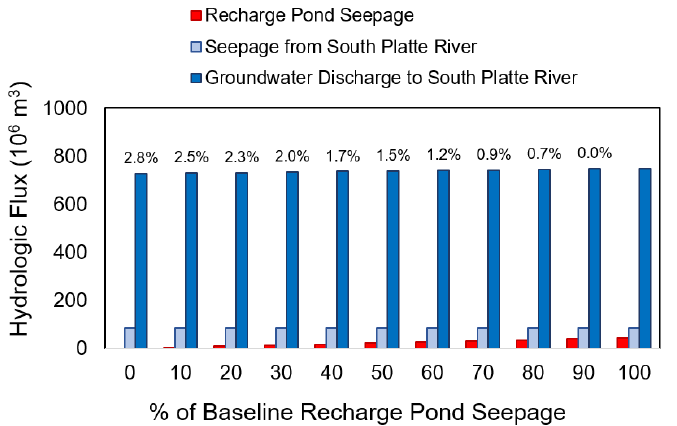
Figure 9. The interaction between the aquifer and the South Platte River corresponds to these different scenarios. X -axis is the percent of baseline recharge pond seepage. The percent values above the bars are percent decrease in groundwater discharge from the baseline simulation. The furthest right bars are for the baseline simulation.